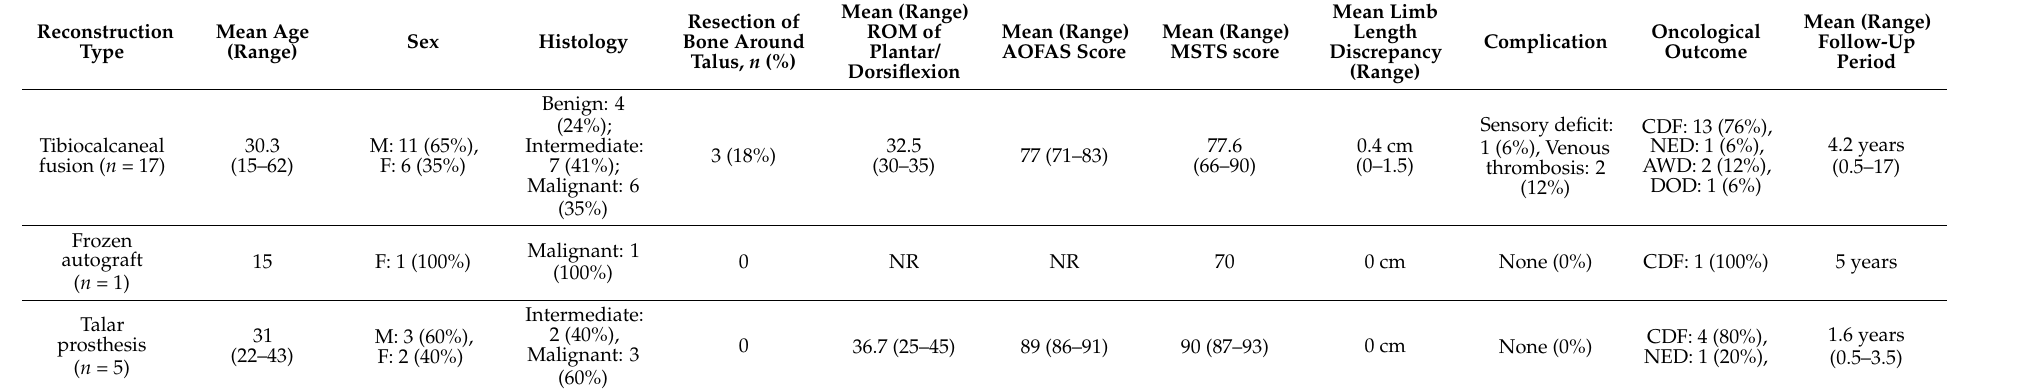
Table 3. Summary of functional outcomes and complications for each reconstruction